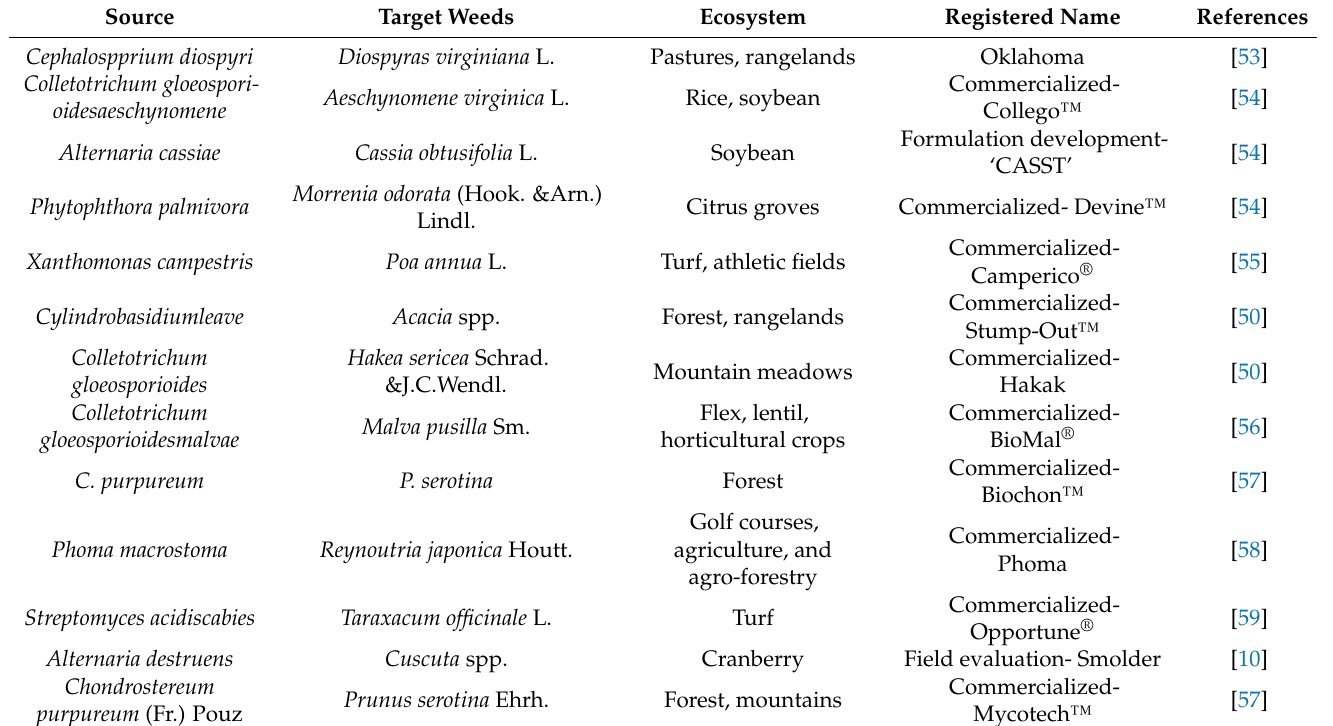
Table 2. Bioherbicides and their respective sources, target weeds, ecosystems, and registered names.